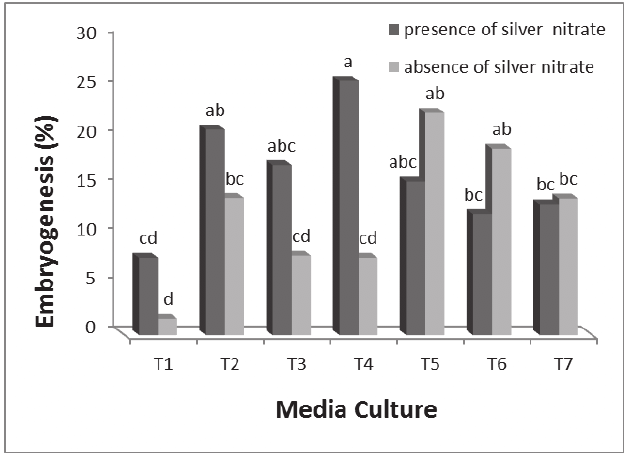
Fig. 3: Interaction effects of silver nitrate and different hormonal combina- tions on embryogenesis. Means followed by a common letter are not significantly different at 5% level according to LSD test T 1 : IBA+2,4-D+TDZ+KIN+BAP (0.8+1+1+0.5+1.5 mg·l -1 ); T 2 : NAA+2,4- D+TDZ+BAP (0.1+0.3+1+2 mg·l -1 ), T 3 : 2,4-D+TDZ+KIN (1.5+0.5+1.5 mg·l -1 ); T 4 : NAA+2,4-D+TDZ+BAP (0.5+0.5+0.5+1.5 mg·l -1 ), T 5 : 2,4-D+ KIN+BAP (1.5+1+1.8 mg·l -1 ); T 6 : NAA+KIN+BAP (0.1+1.5+1.5 mg·l -1 ), T 7 :